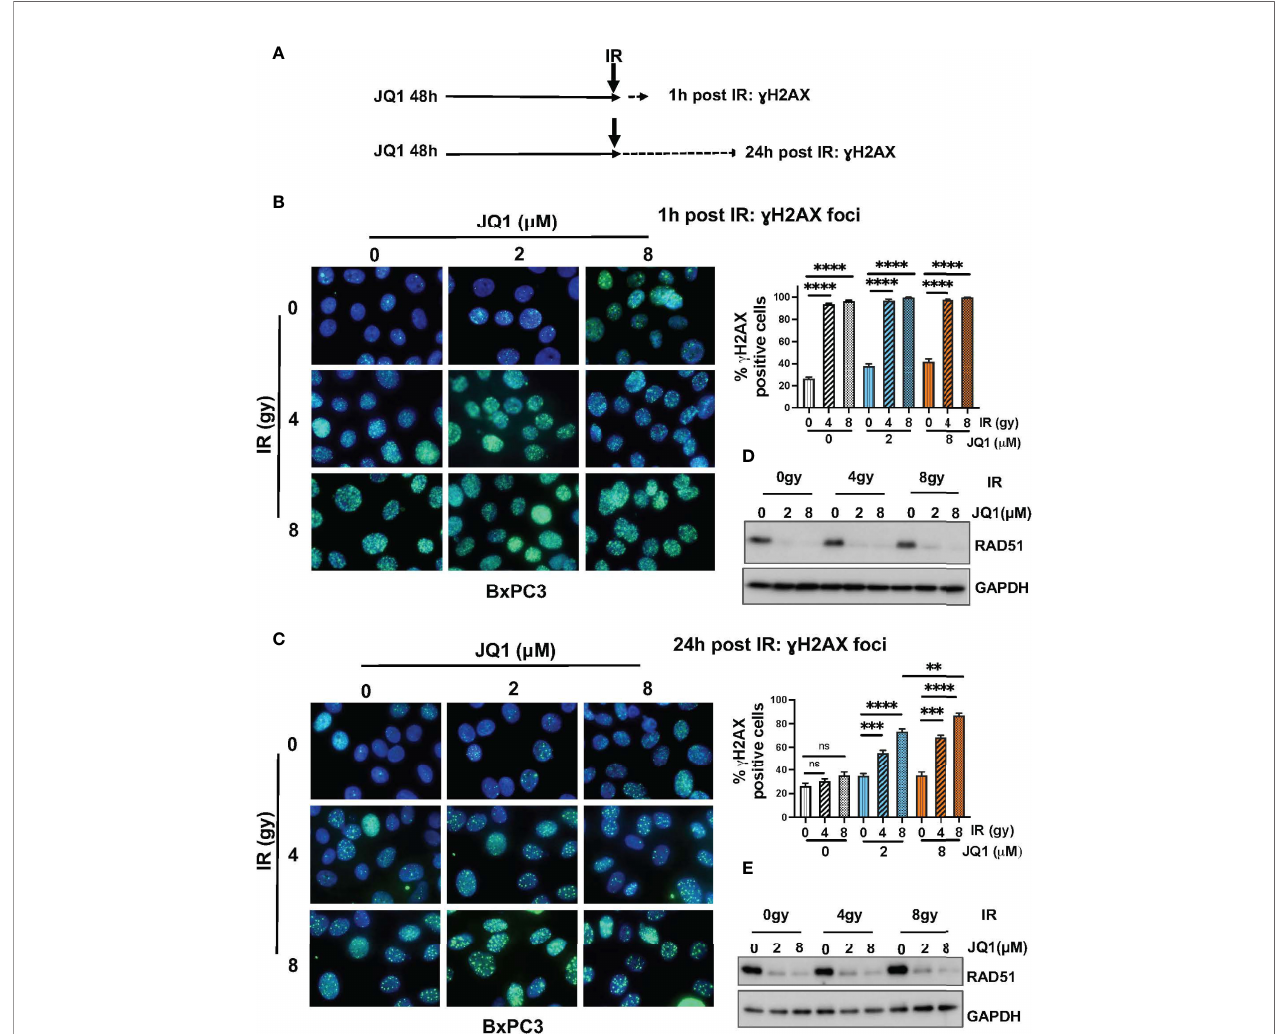
FIGURE 2 | Immuno fl uorescence and immunoblot data show that JQ1 + IR increases levels of the DNA damage marker g H2AX and decreases levels of the DNA repair protein RAD51 in BxPC3 cells. The combination is more effective than either single modality. (A) Schematic of exposure and harvest times of cells exposed to JQ1 and IR prior to evaluating levels of g H2AX and RAD51. (B, C) Images of representative immuno fl uorescence (IF) data at (B) 1 hour post IR or (C) 24h post IR. Quantitation of g H2AX foci is presented on bar graphs to the right of the IF images. (D, E) Representative immunoblots for RAD51 at (D) 1 hour and (E) 24 hours post IR. One-Way ANOVA followed by Tukey multi comparison analysis was performed as described in Materials and Methods. **p < 0.01, ***p < 0.001, ****p < 0.0001. ns, not signi fi